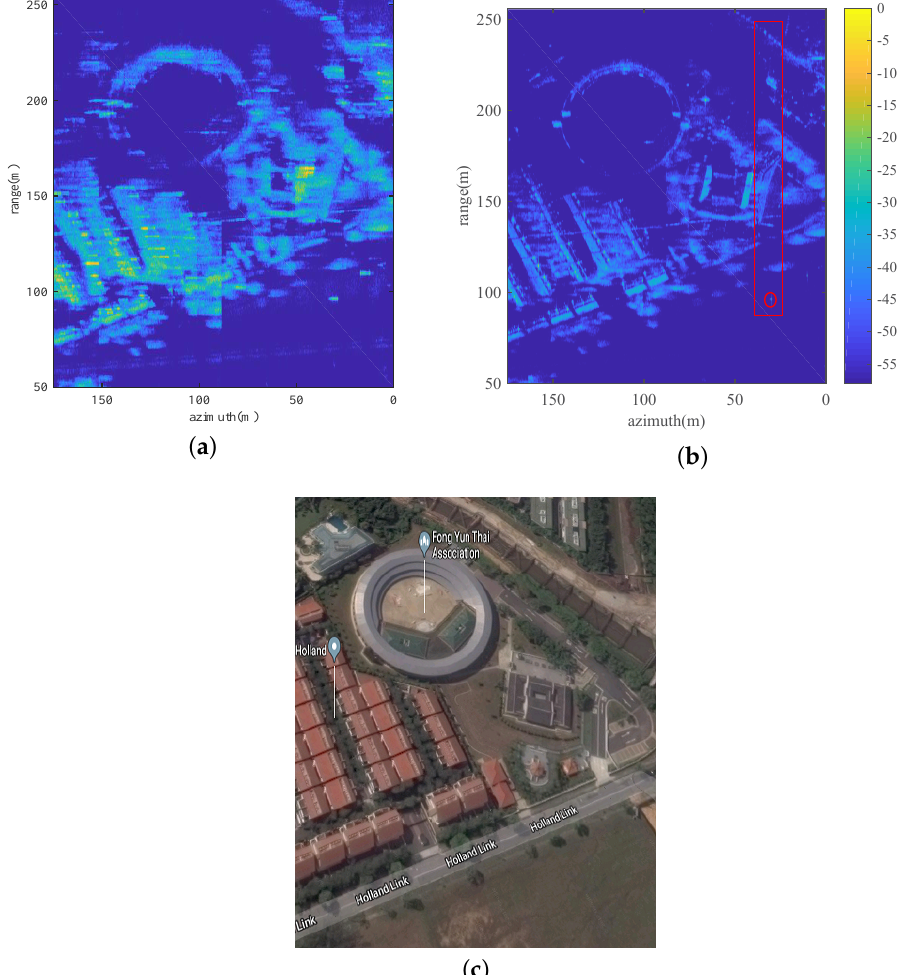
Figure 4. Real data experiments: ( a ) focusing result without MoCo, ( b ) fully focused SAR image, ( c ) optical image of trial scene from Google